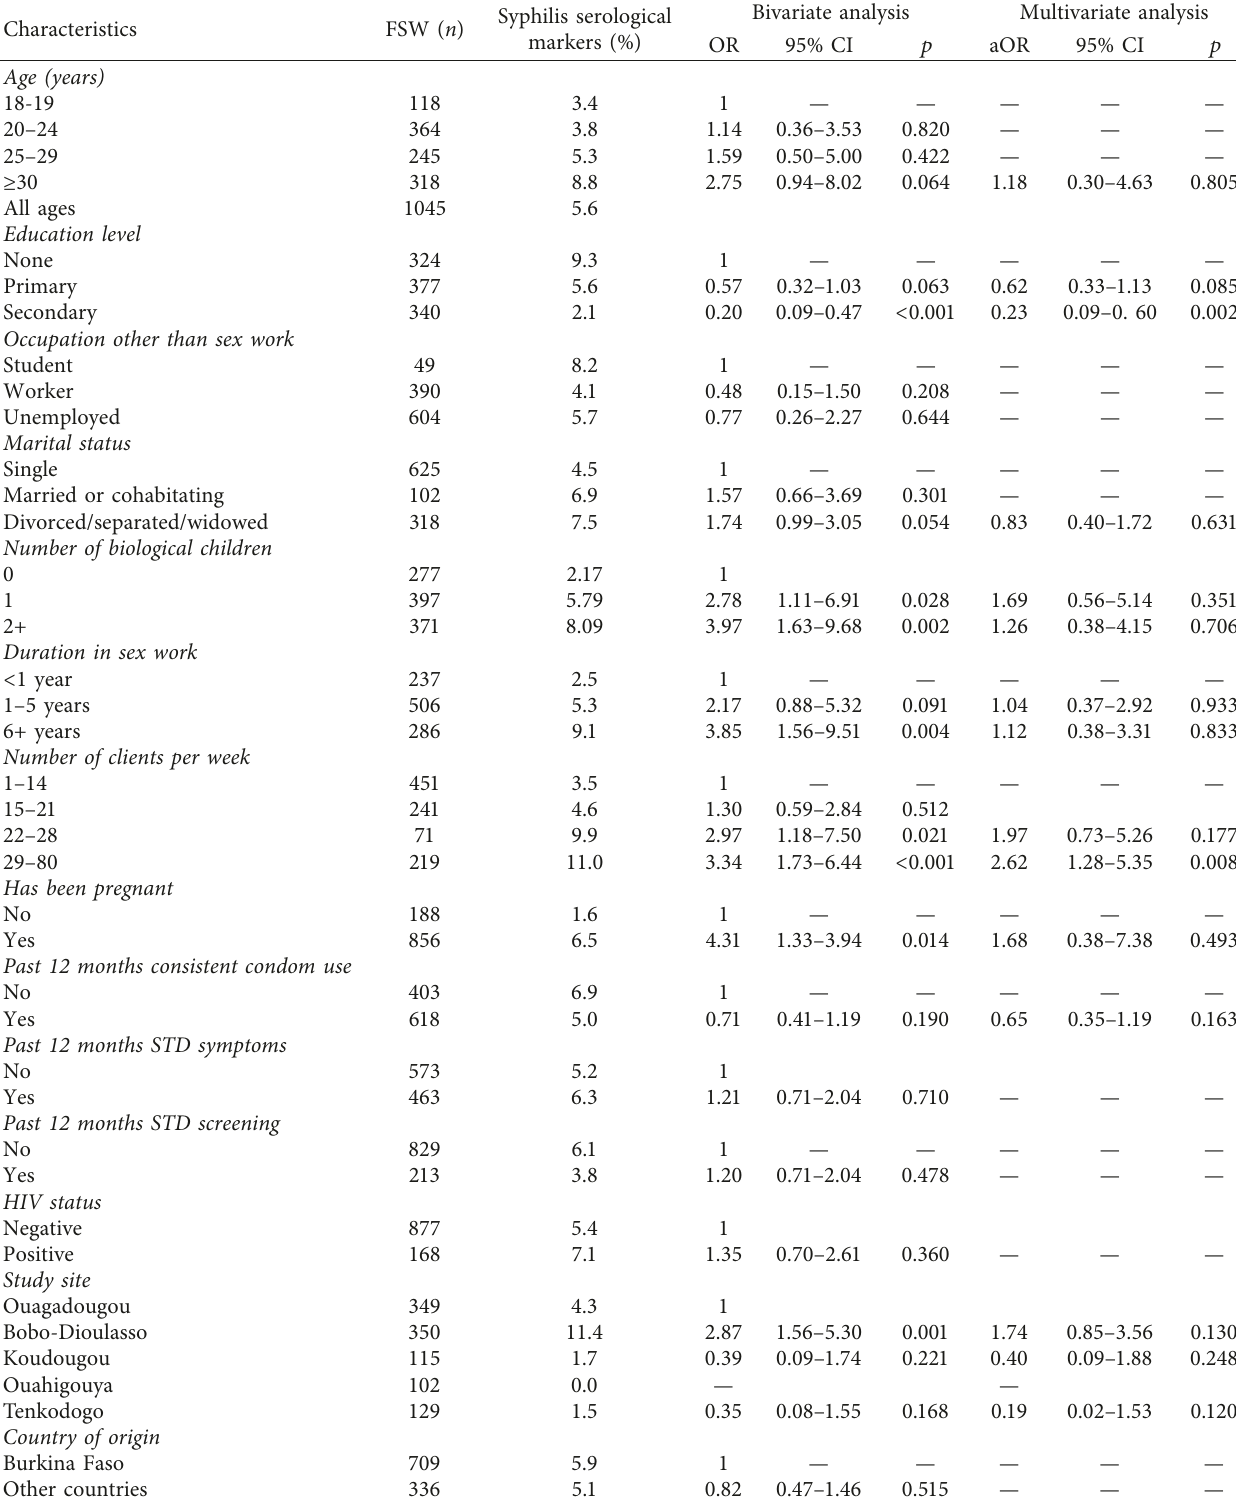
Table 4: Factors associated with syphilis serological markers among female sex workers in Burkina Faso.